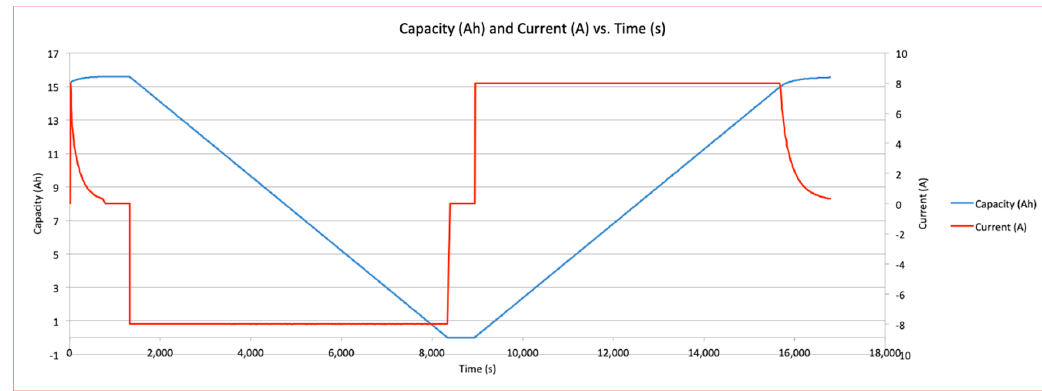
Figure 15. Battery individual cell testing: Voltage and current vs. time.